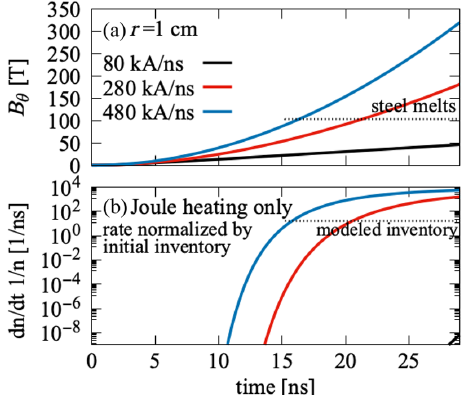
FIG. 4. (a) B θ ð t Þ at the cathode ( r ¼ 1 cm) in the kinetic breakdown simulations for the three current rises. The dashed line is the melting point from Eq. (1). (b) The normalized desorption rates from Eqs. (4) and (5) for the three current rises calculated from Joule heating [Eq. (1)] only. The dashed line represents the assumed